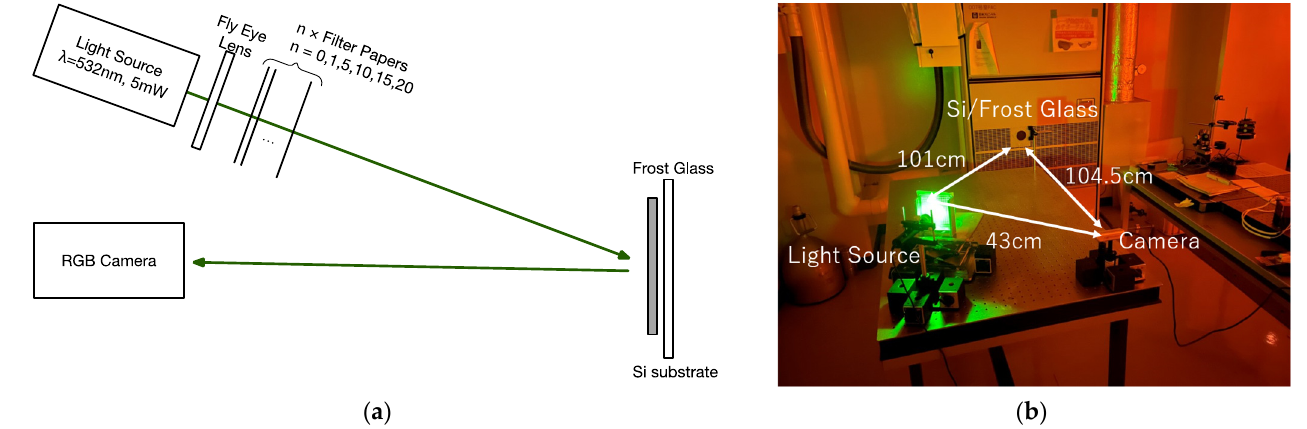
Figure 3. Configurations of experiments: ( a ) Experiment apparatus; ( b ) Setup of experiments.